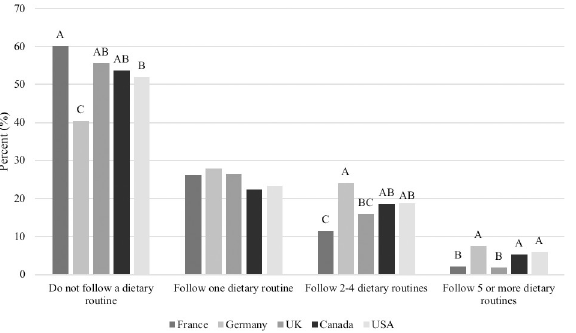
Fig 1. Number of dietary routines followed by respondents in each country (n = 3,298). Proportions in the same category that do not share a common letter are significantly different at P < 0.05.